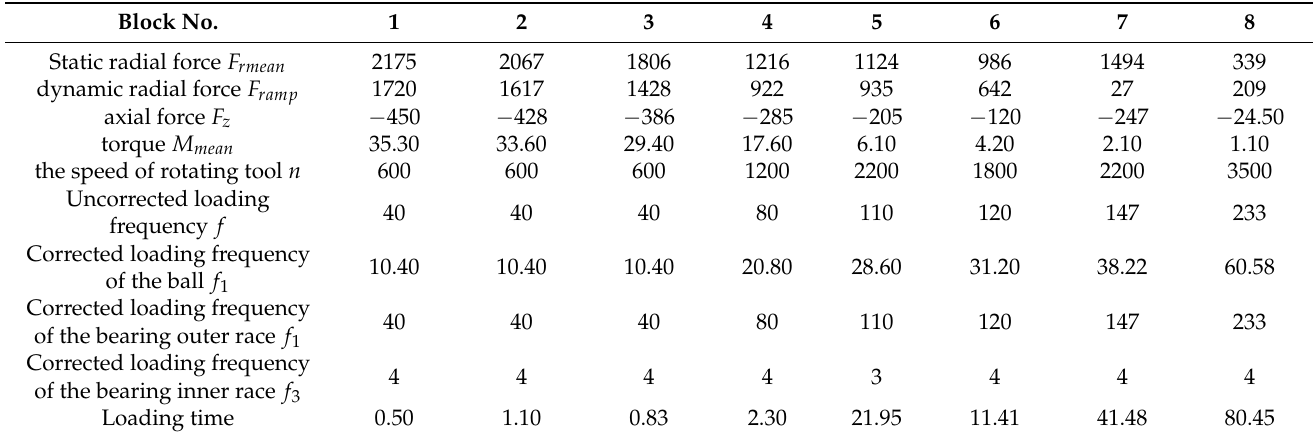
Table 4. Loading spectrum based on general load model in RAT coordinates.